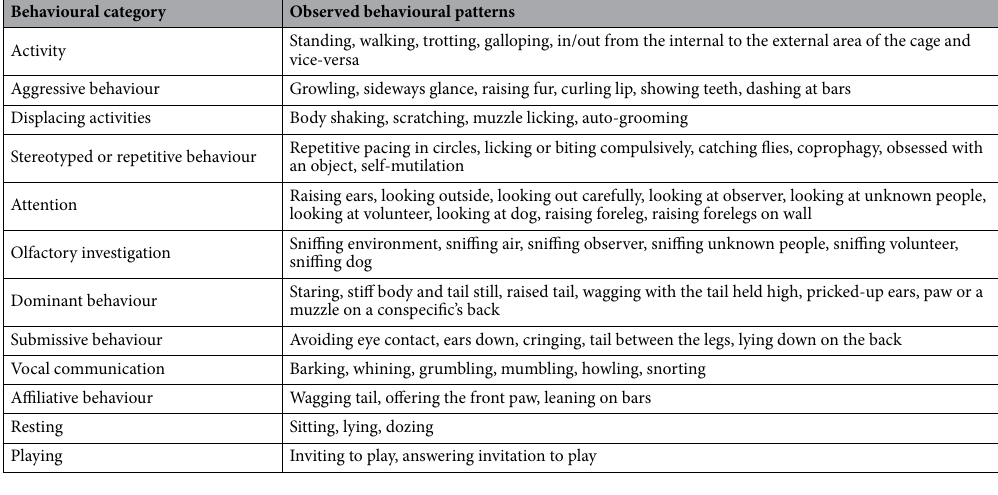
Table 2. The behavioural patterns utilised in this study grouped into categories. For the description of the behaviours, see Supplementary